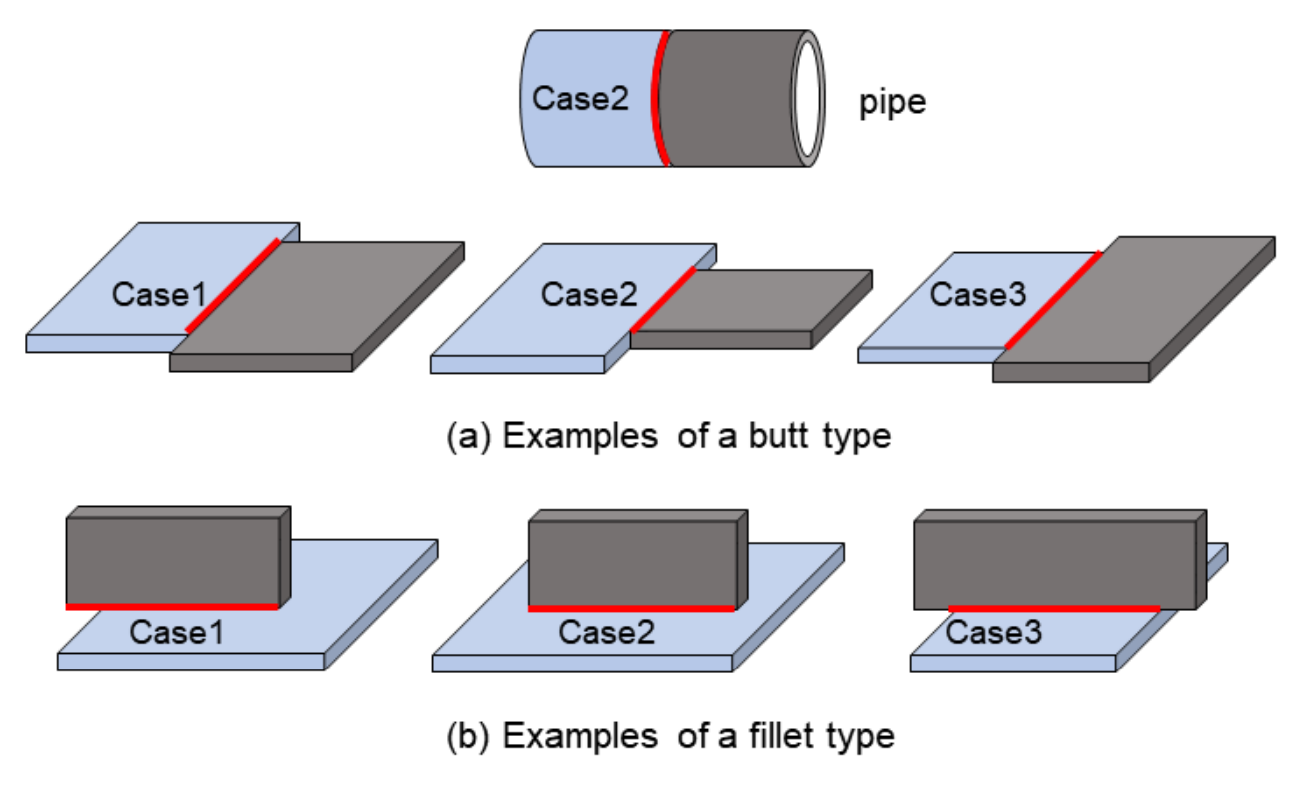
Figure 8. Weld lines generated for butt and fillet types.